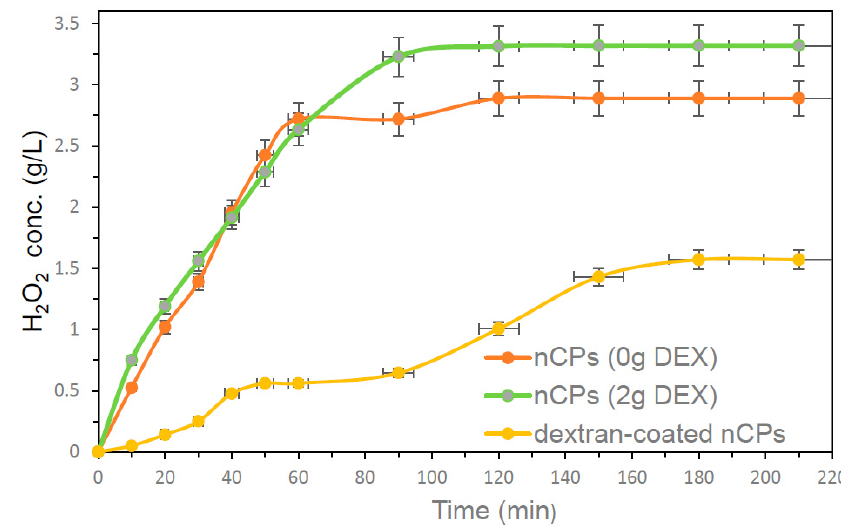
Figure 11. The H 2 O 2 release profiles of nCPs and dextran-coated nCPs (DEX).